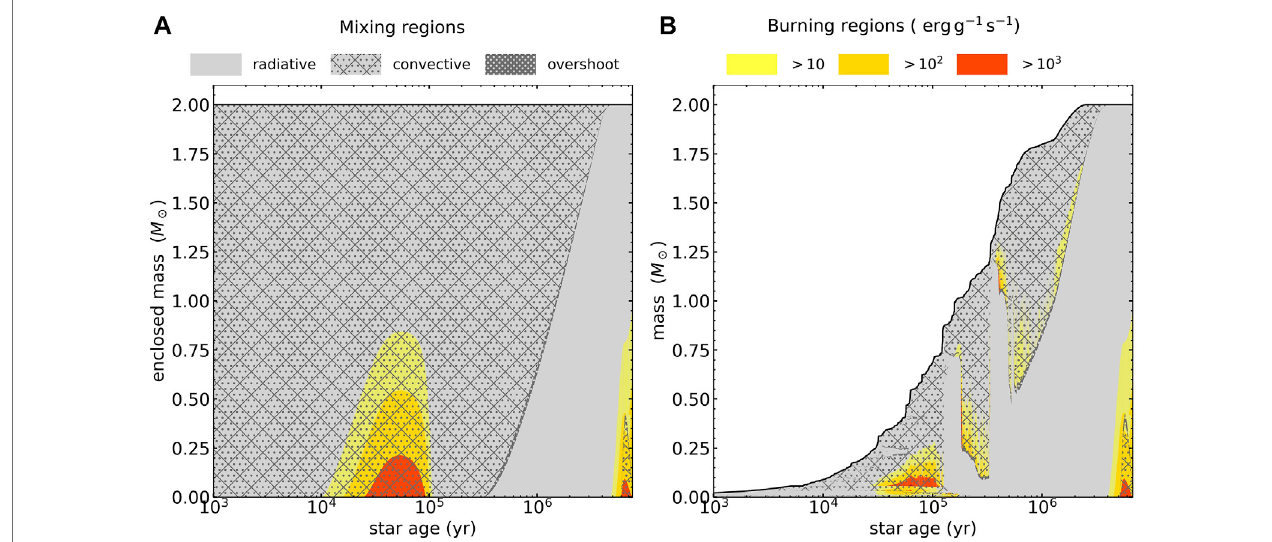
FIGURE 1 | Kippenhahn diagram of the pre-main sequence evolution. (A) classical model. (B) model including accretion effects (Steindl et al., 2022) with disk- mediated accretion rates from (Elbakyan et al., 2019). The stellar structure is shown between the stellar centre (enclosed mass = 0) and the black line (enclosed mass = stellar mass). Different mixing regions are indicated by textures. Radiative regions are grey, while overshooting and convective regions are hashed according to the legend. Regions of the star producing energy by nuclear reactions are colored according to the energy rate and the